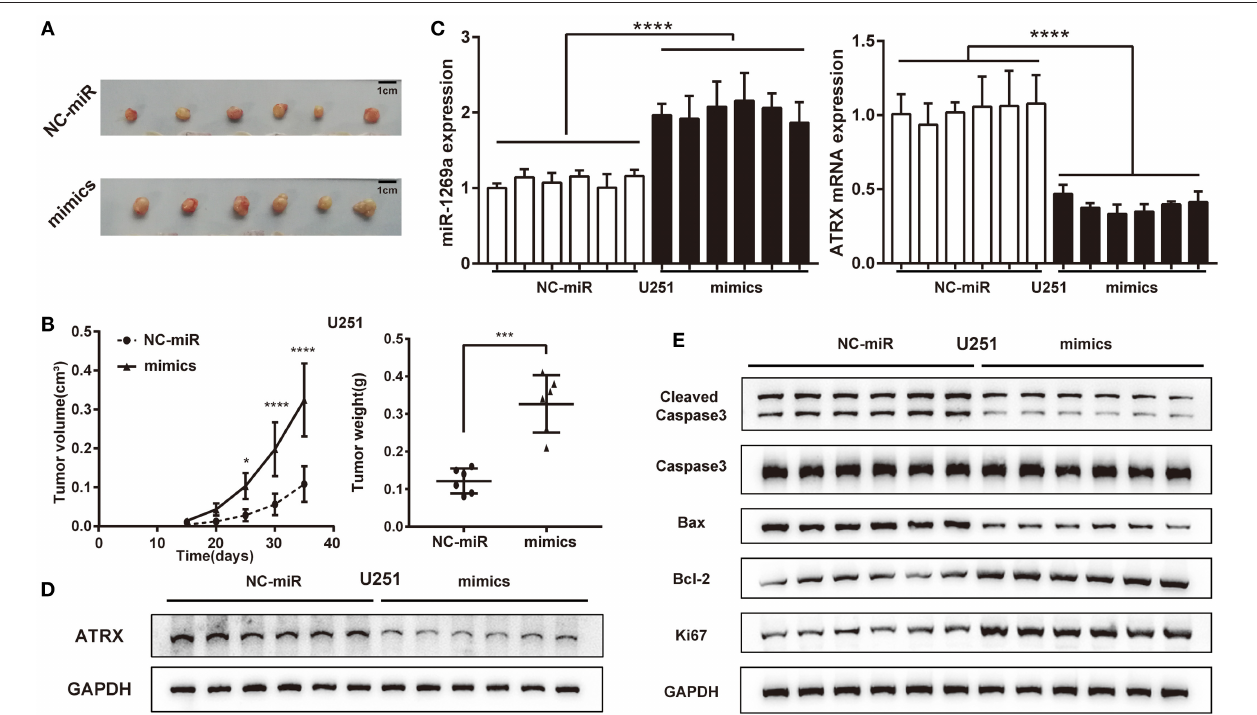
FIGURE 5 | miR-1269a promotes glioma tumorigenesis in vivo . (A) A subcutaneous xenograft tumor model was used to observe the effect of U251 + pLVX-miR- 1269a-mimics on tumor growth. (B) Tumor volume and tumor weight were measured after the injection of pLVX-miR-1269a-mimics. (C) The relative expression levels of miR-1269a and ATRX in the xenograft tumor were detected qPCR and Western blot. (D,E) The protein expression levels of proliferation (Ki67) and apoptosis (cleaved caspase 3, caspase 3, Bax, and Bcl-2) in xenograft tumor were detected via Western blot. * P < 0.05, *** P < 0.001, and **** P <